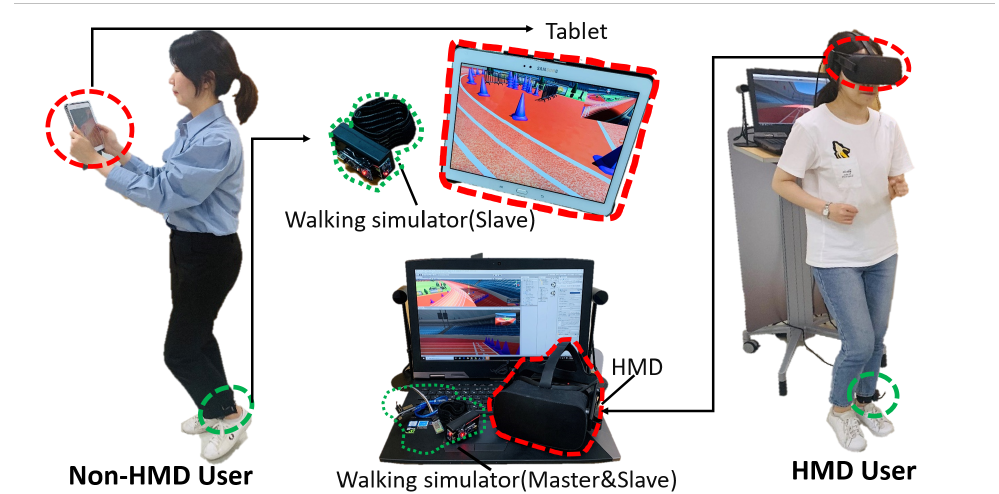
Figure 5. Low-asymmetry system ((Left) Green part: Devices for non-HMD users, including a tablet for visualization and a walking simulator connected to the tablet though Bluetooth. (Right) Red part: HMD gear and walking simulator for the HMD users.)